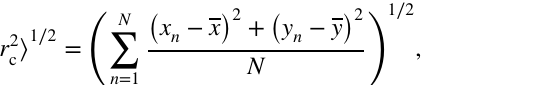
torted beam did not change for different frames, which indi- after propagating through the stationary water tank.